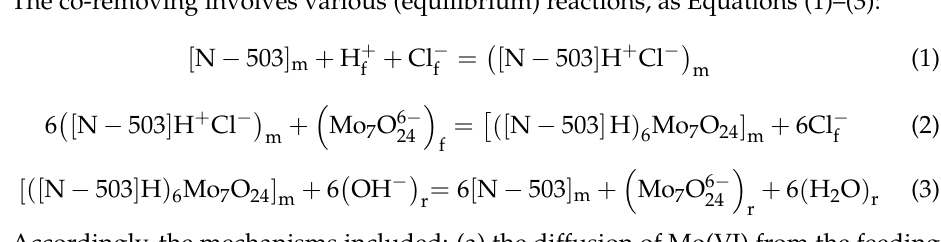
Figure 1. The structure of the membrane chemical reactor with mixed organic-water solvent (MCR- OW).